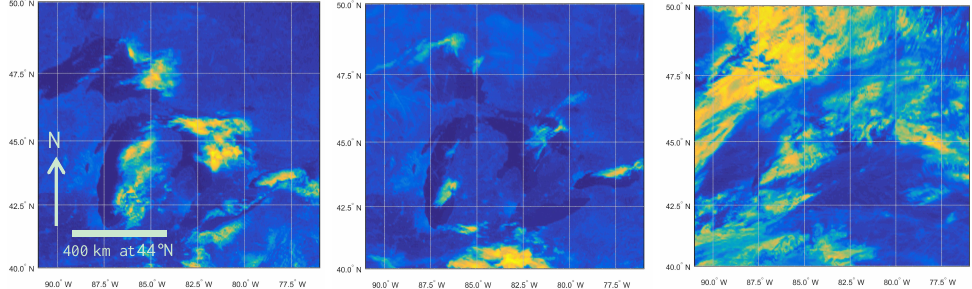
Figure 4. 3.9 µm reflective at 1830 UTC for 27 February–1 March 2015. Bright yellows are high R2 values indicative of clouds.